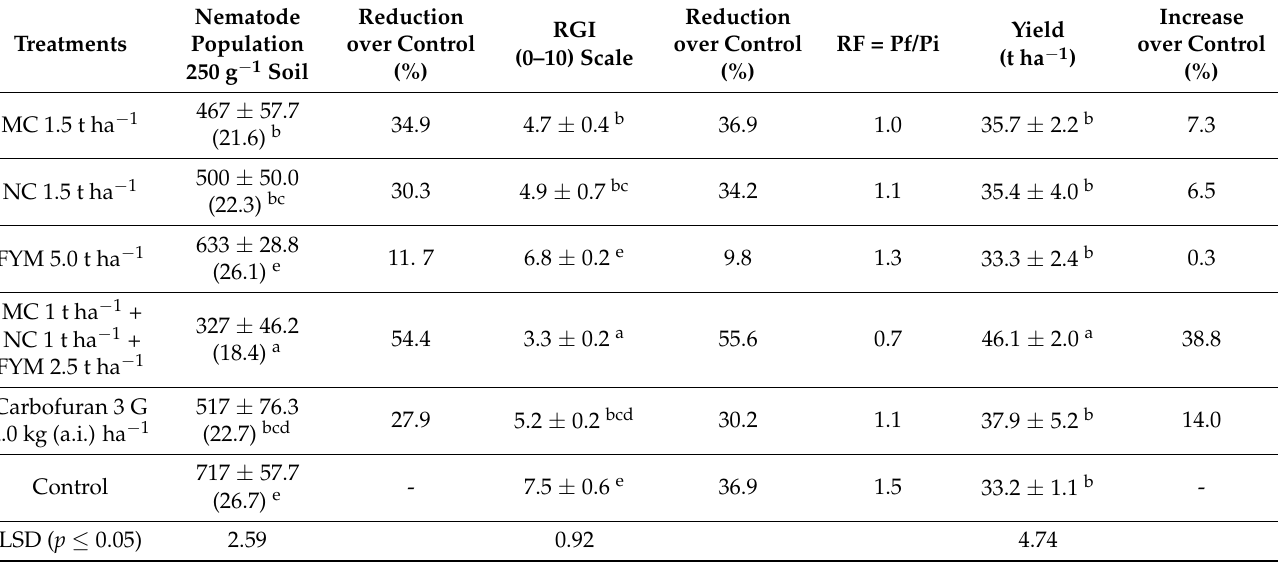
Table 5. Effects of different amendments on root-knot nematode infestation and yield of cucumber (var. KUK-9) in a commercial polyhouse (polyhouse-III, farmer’s